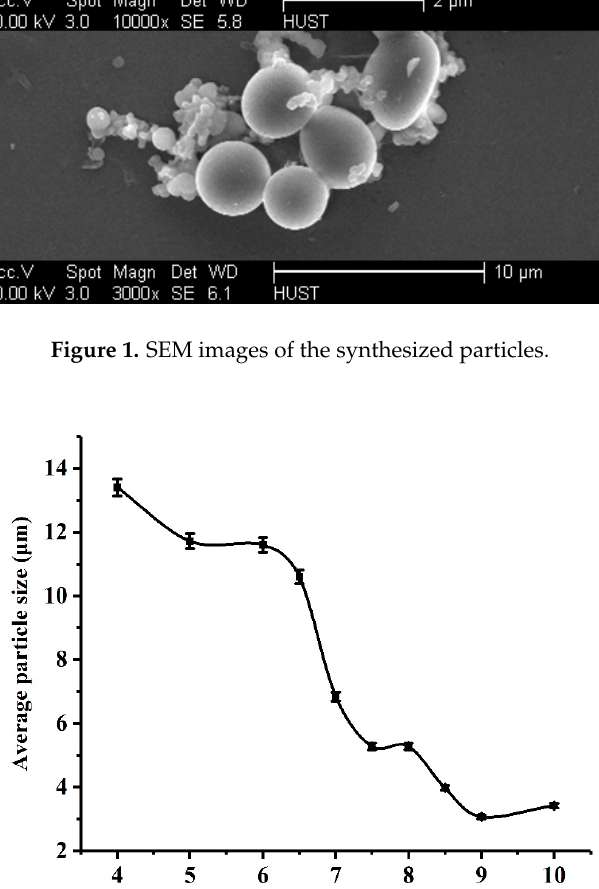
Figure 2. Average particle sizes variation of the synthesized matrix in different solution pH values.